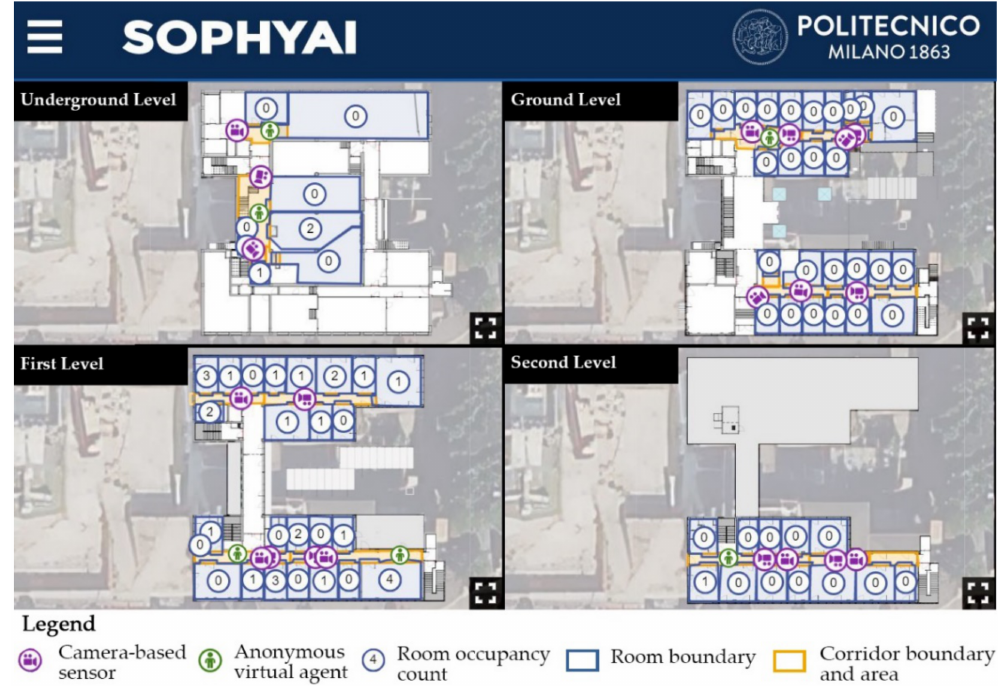
Figure 8. Visualization of real time data in the online platform during test